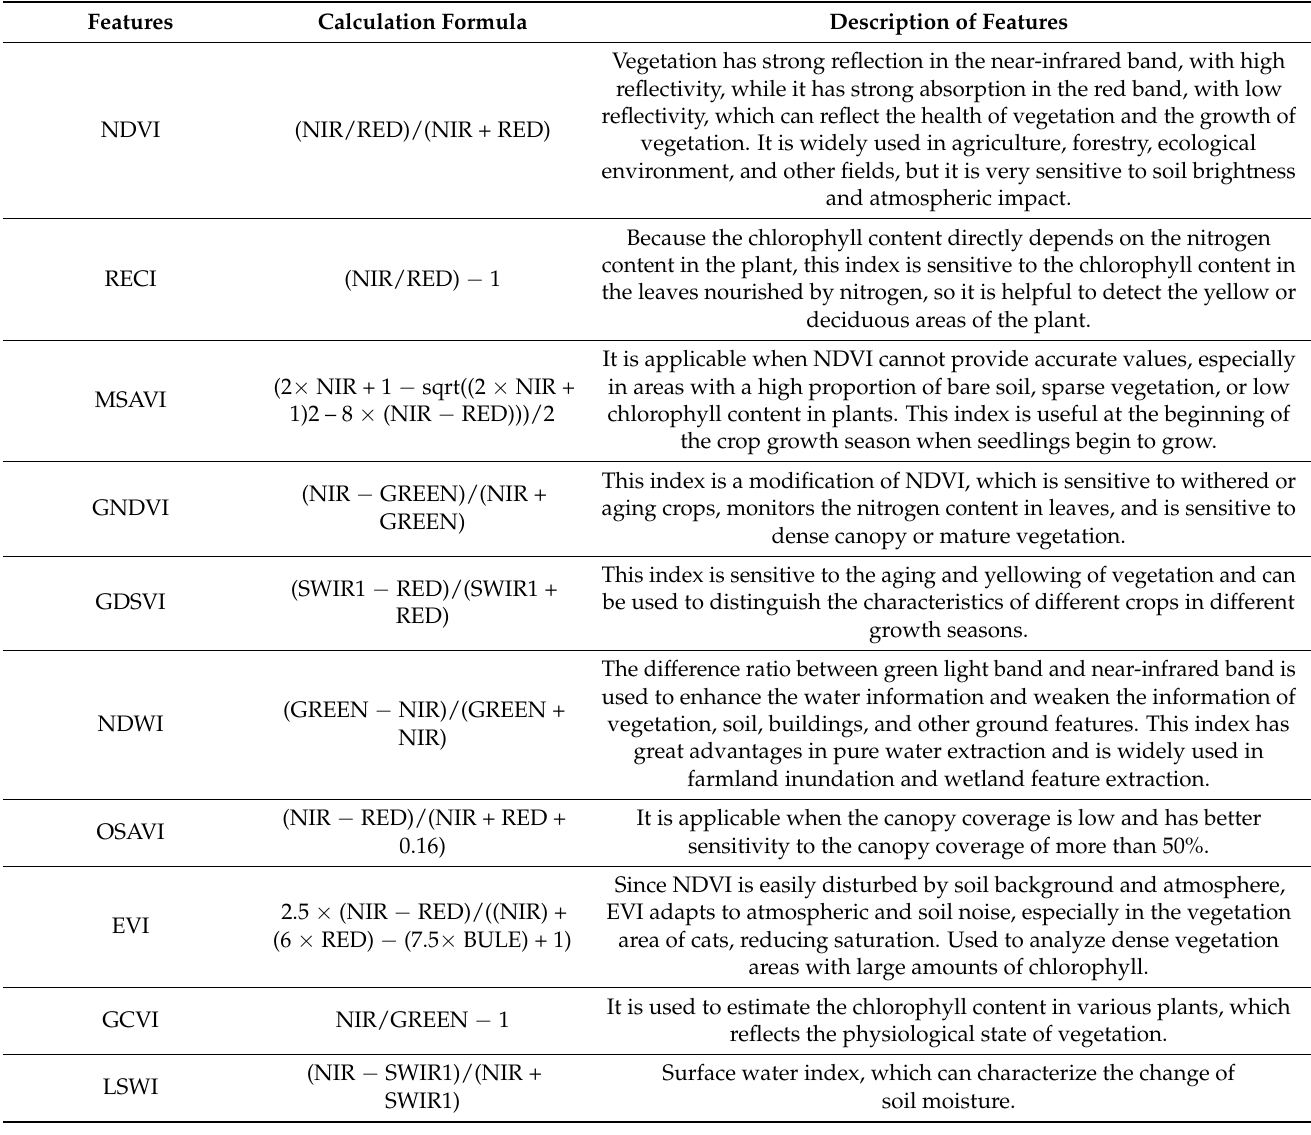
Table 1. The calculation formulae and characteristic descriptions of the vegetation